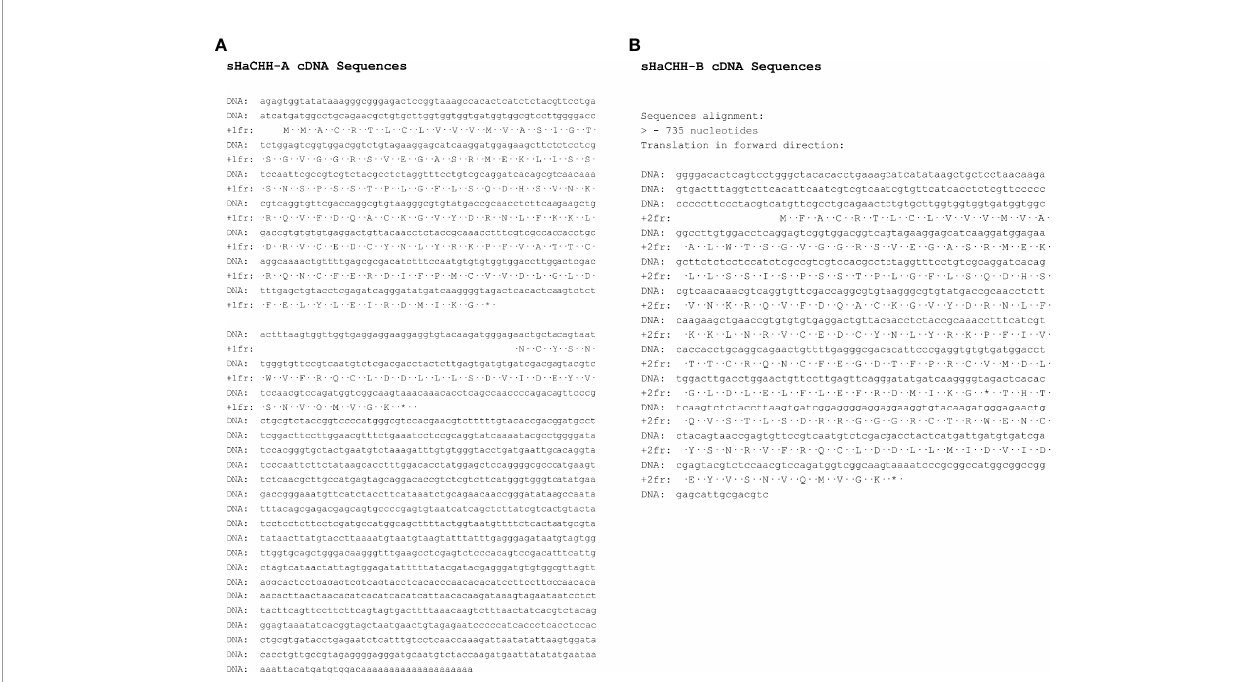
FIGURE 3 | Nucleotide and deduced amino acid sequences of the computed cDNA for sHaCHH-A (A) and sHaCHH-B (B) . A one-letter amino acid code was used to indicate the amino acid